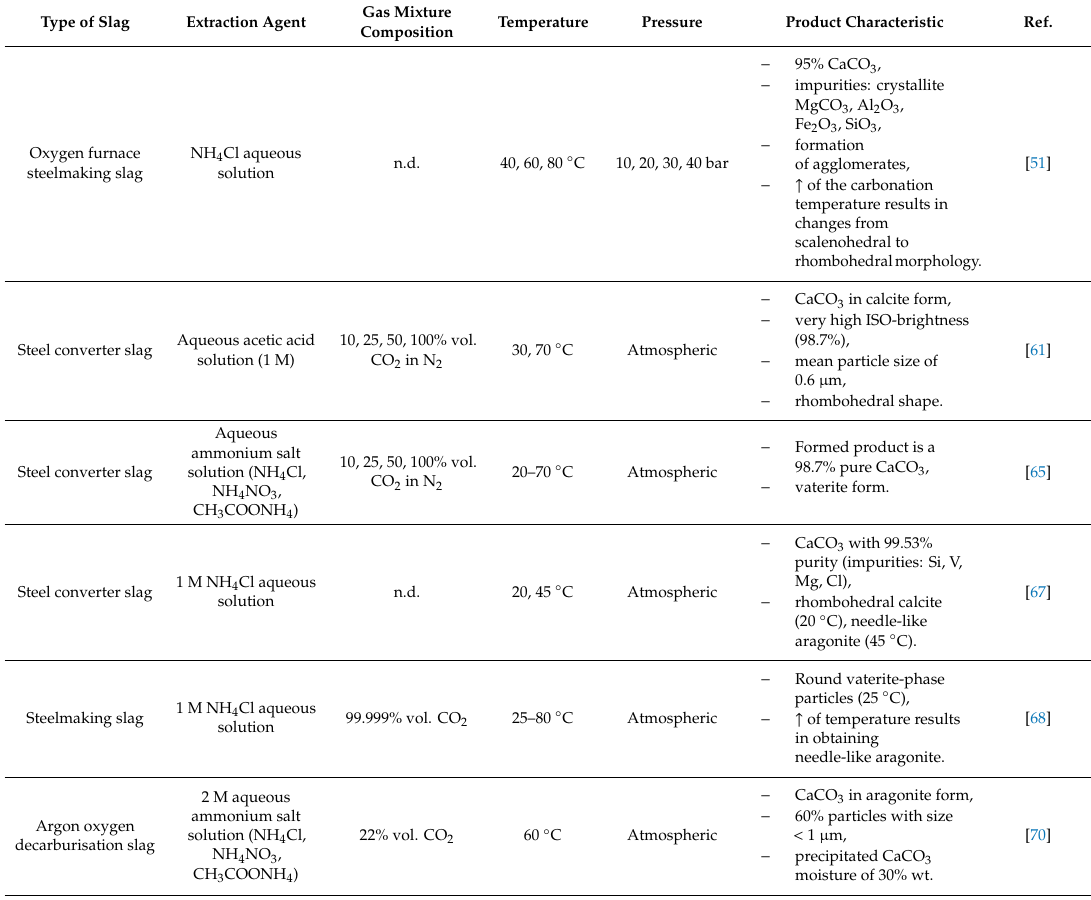
Table 3. Process parameters of CaCO 3 precipitation technologies for steelmaking slag utilization using carbonation